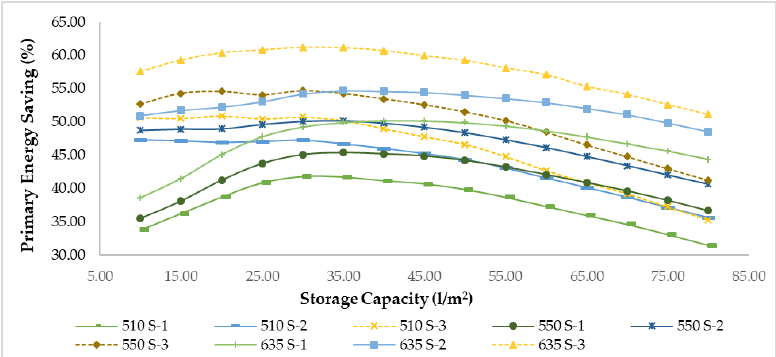
Figure 8. The trend of storage sizes for flat plate collector (FPC) areas of 50% PES for all flow